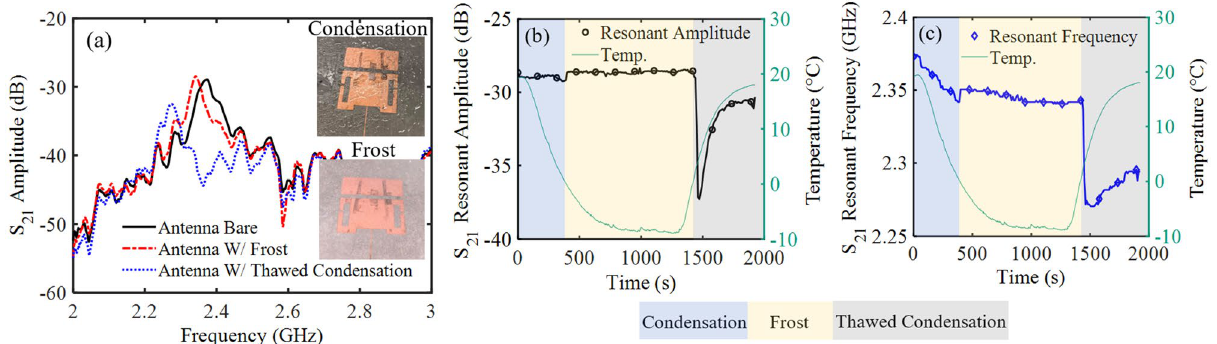
Figure 8. Measured S 21 parameters after allowing condensed water and frost to develop on the antenna. The ( a ) spectrum response of the transmitted signal, ( b ) resonant amplitude tracked over time, and ( c ) resonant frequency tracked over